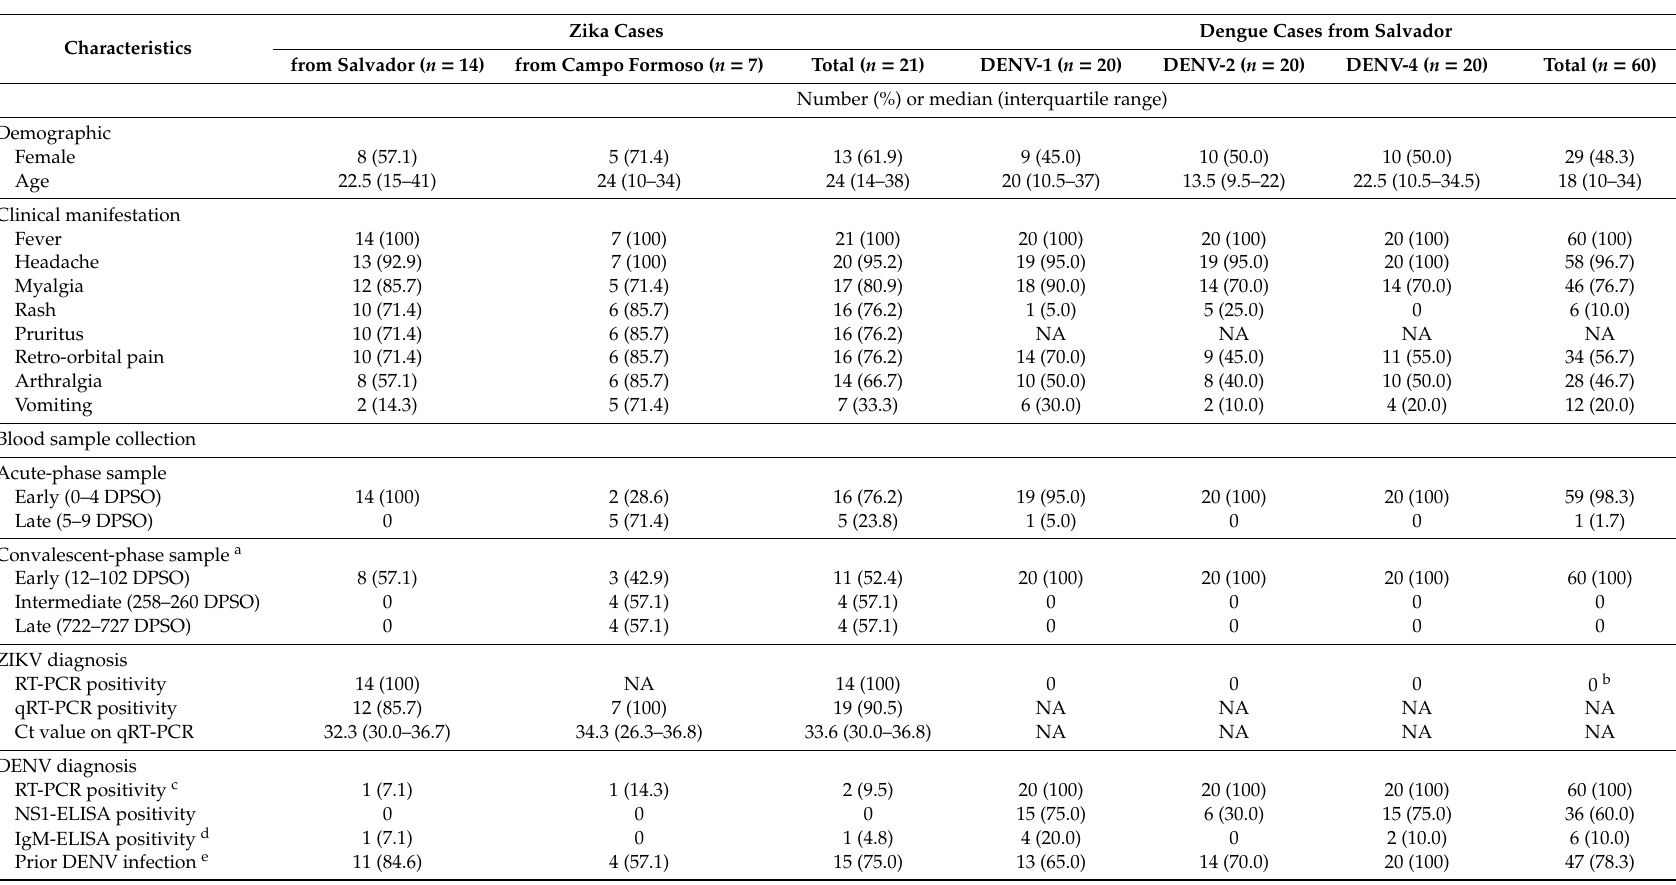
Table 1. Demographic, clinical and laboratorial characteristics, and serum sample availability for RT-PCR-confirmed Zika ( n = 21) and dengue ( n = 60) cases.